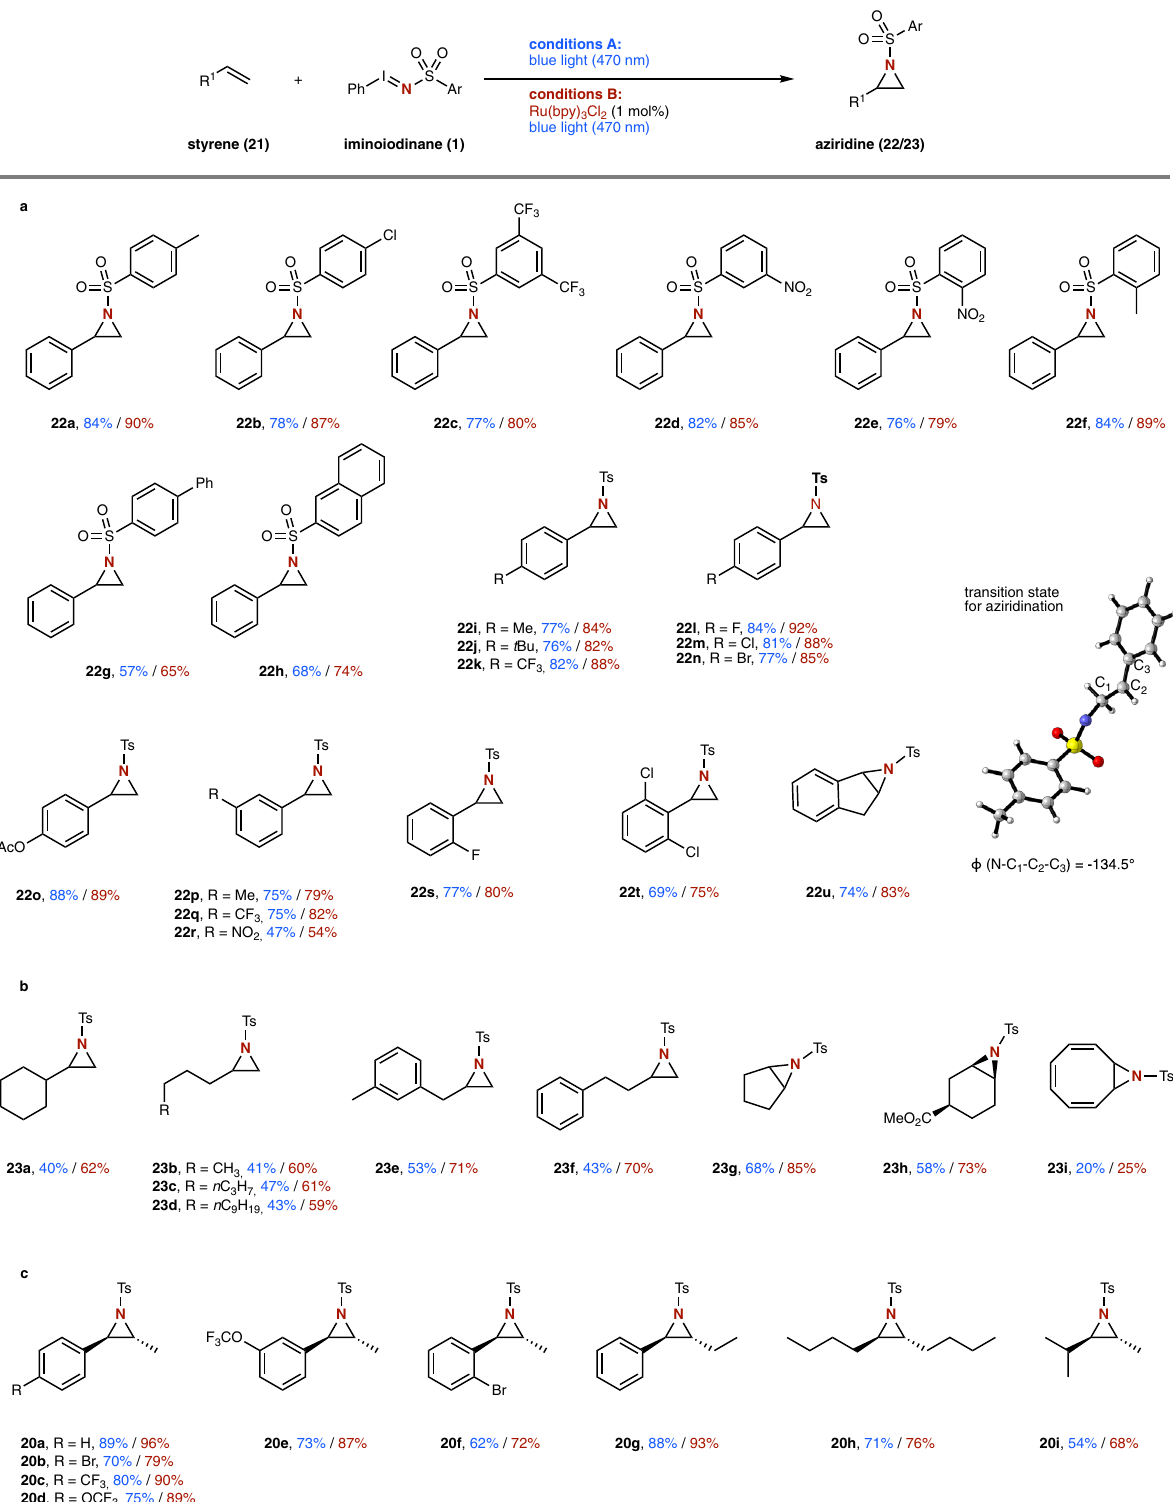
20a , R = H, 89% / 96% 20b , R = Br, 70% / 79%